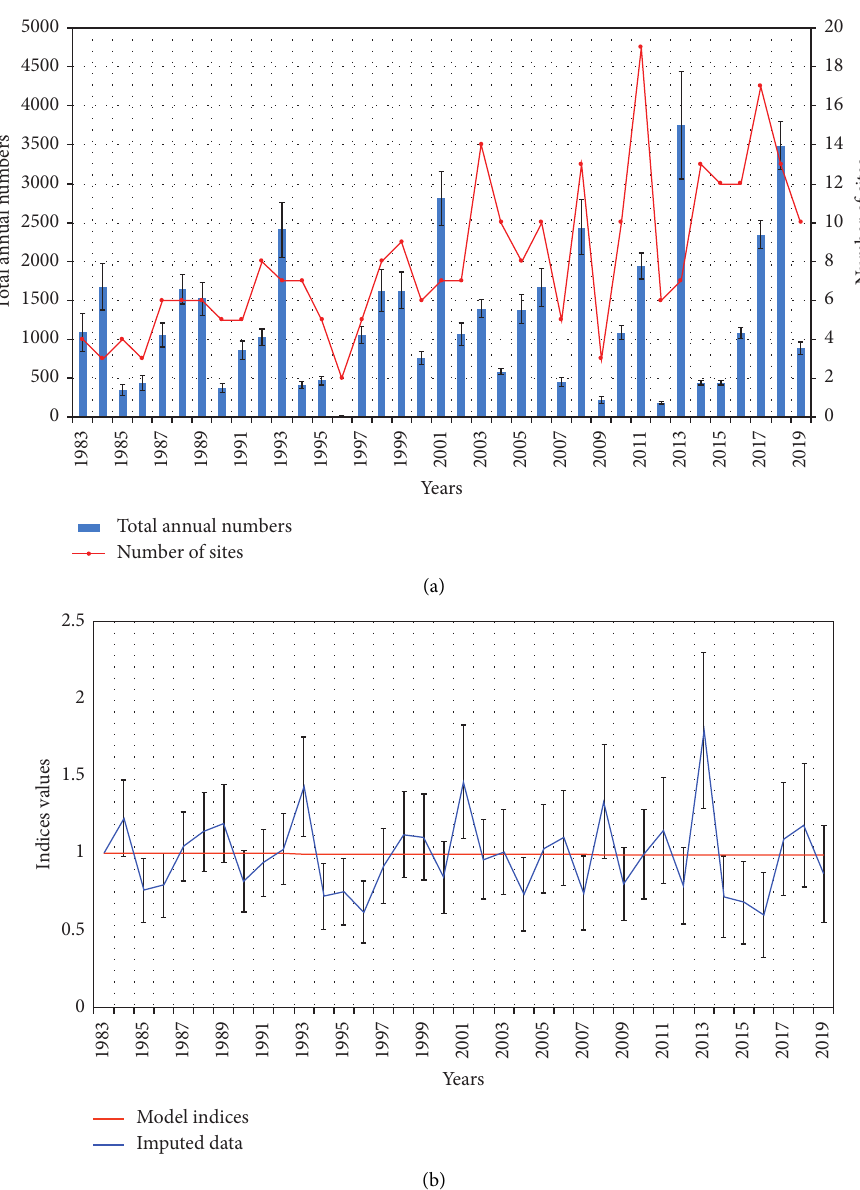
Figure 2: (a) Total annual numbers of the Marbled Teal and the number of wetlands where it has been observed in Morocco between 1983 and 2019. (b) Linear trend of the wintering population (TRIM